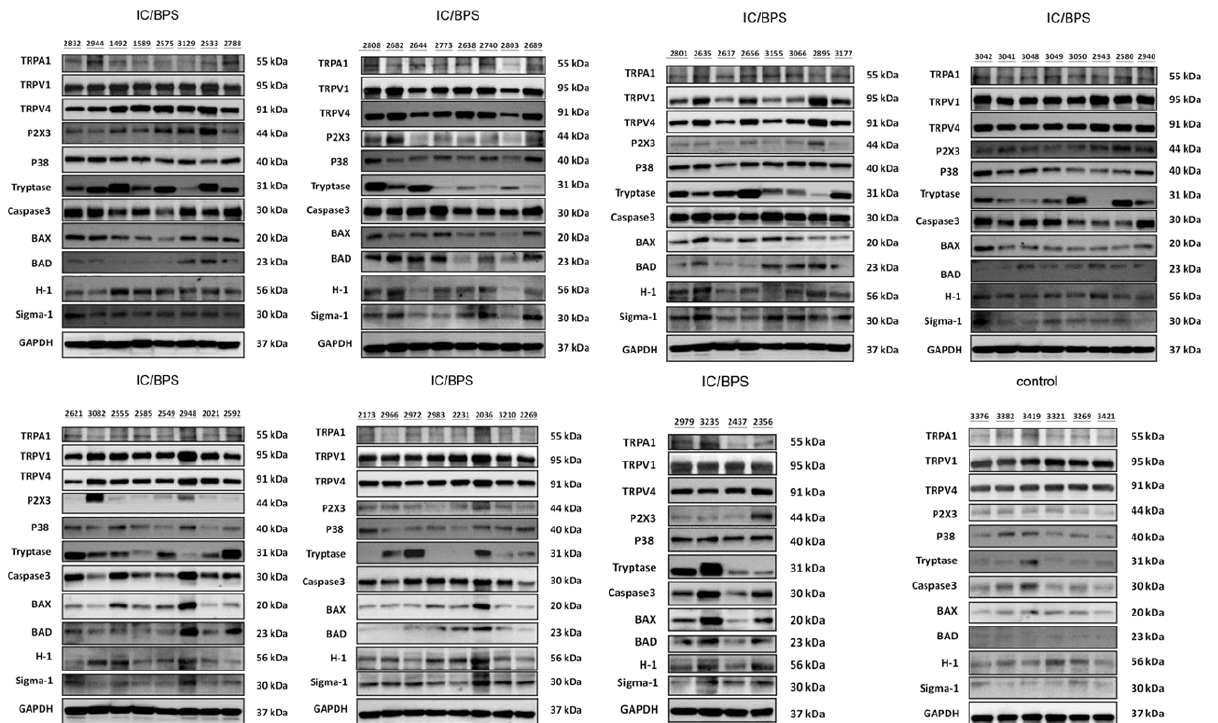
Figure 2. Western blots of bladder urothelial sensory receptors (TRPA1, TRPV1, TRPV4, P2X3, H-1, and sigma-1), and inflammatory (p38, tryptase) and pro-apoptotic proteins (caspase-3, BAX, BAD) in the bladder urothelium of IC/BPS patients and controls. More IC/BPS patients showed higher expression levels of TRPV1, TRPV4, sigma-1 receptors, P38, tryptase, caspase 3, and BAD expressions than controls. Molecular weight (kD) is indicated to the right of the blot. The GAPDH was blotted and used as a loading control. Table 2 shows the sensory, inflammatory, and pro-apoptotic protein expressions in the urothelium of the IC/BPS patients and controls. The TRPV1, TRPV4, sigma-1 receptors, P38, tryptase, caspase 3, and BAD expression levels were higher in patients with IC/BPS compared with the controls. Except for TRPA1 and H-1, the other sensory receptors, and with the controls. Table 2. The sensory, inflammatory, and pro-apoptotic protein expression levels in the urothelium of patients with interstitial cystitis/bladder pain syndrome and controls. Bladder Protein